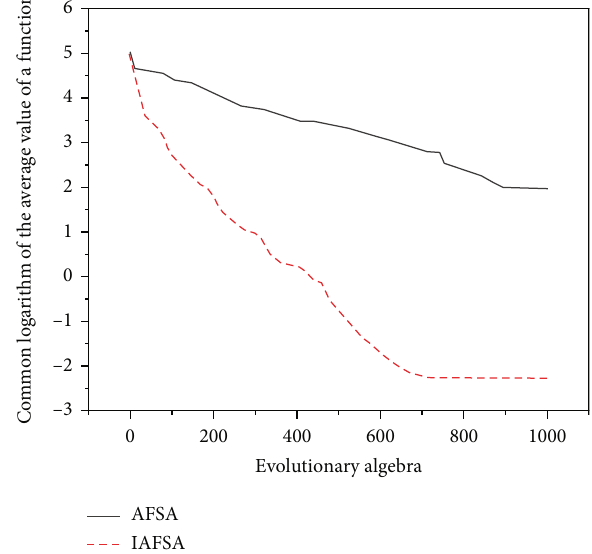
Figure 11: Evolution curve of average optimal value of function f